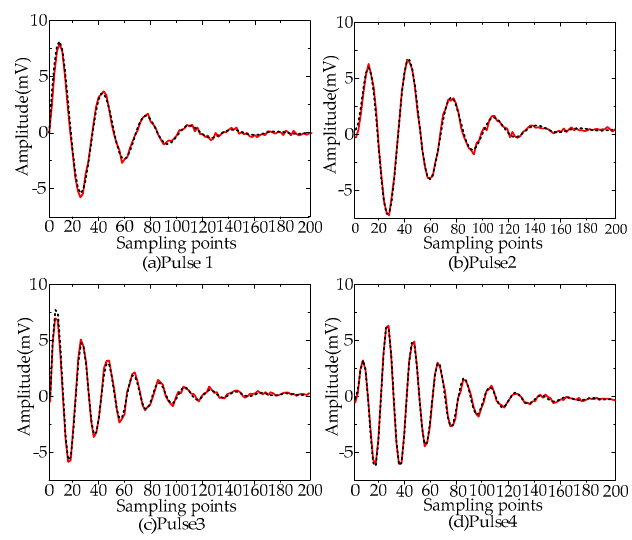
Figure 12. Comparisons of the original and the de-noised PD pulse shapes. ( a ) Pulse 1; ( b ) Pulse 2; ( c ) Pulse 3; ( d ) Pulse 4.